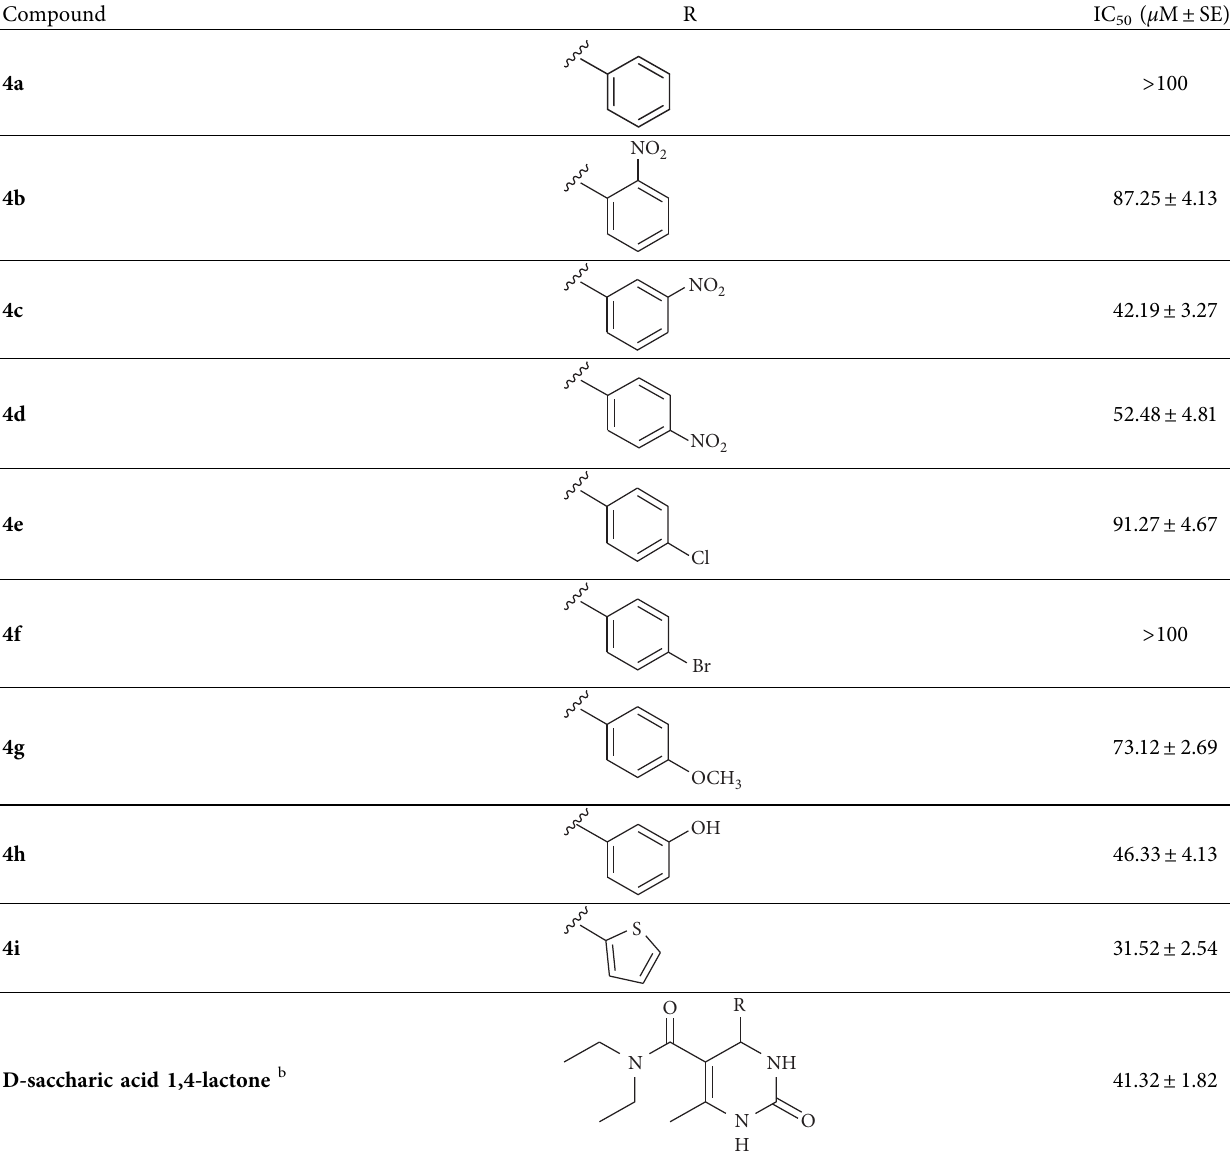
Table 1: β -glucuronidase inhibitory activity of the dihydropyrimidinone